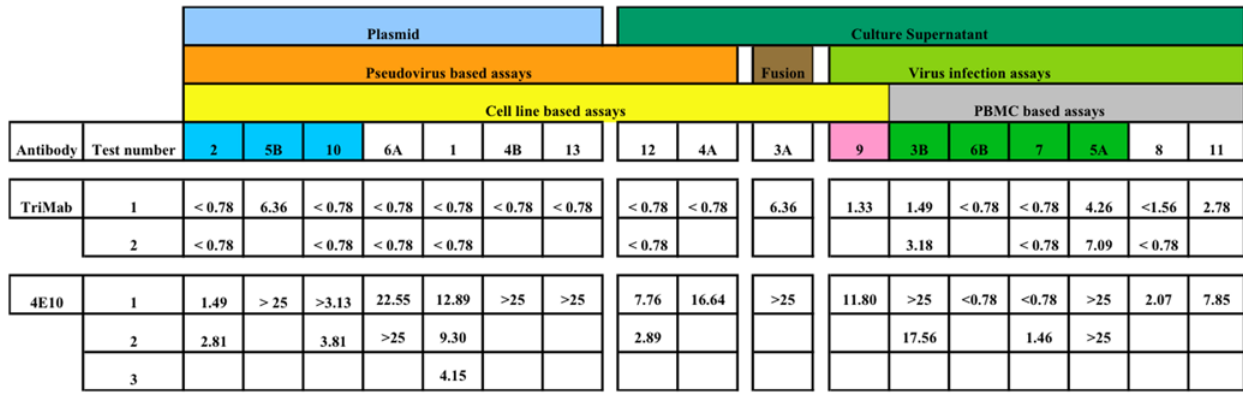
Figure 2. Intra-lab variation of neutralization performed with SF162. Light blue coded laboratory performed TZM-bl assay; green coded laboratory performed extracellular p24 reduction readout assay and pink coded laboratory performed placque reduction assay. Assays are grouped as in Figure 1.